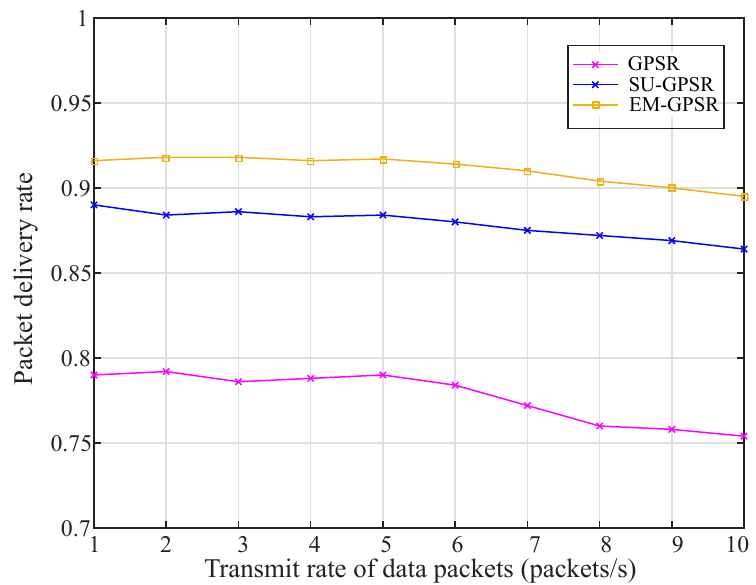
Figure 13. Packet delivery rates versus transmit rate of data packets.